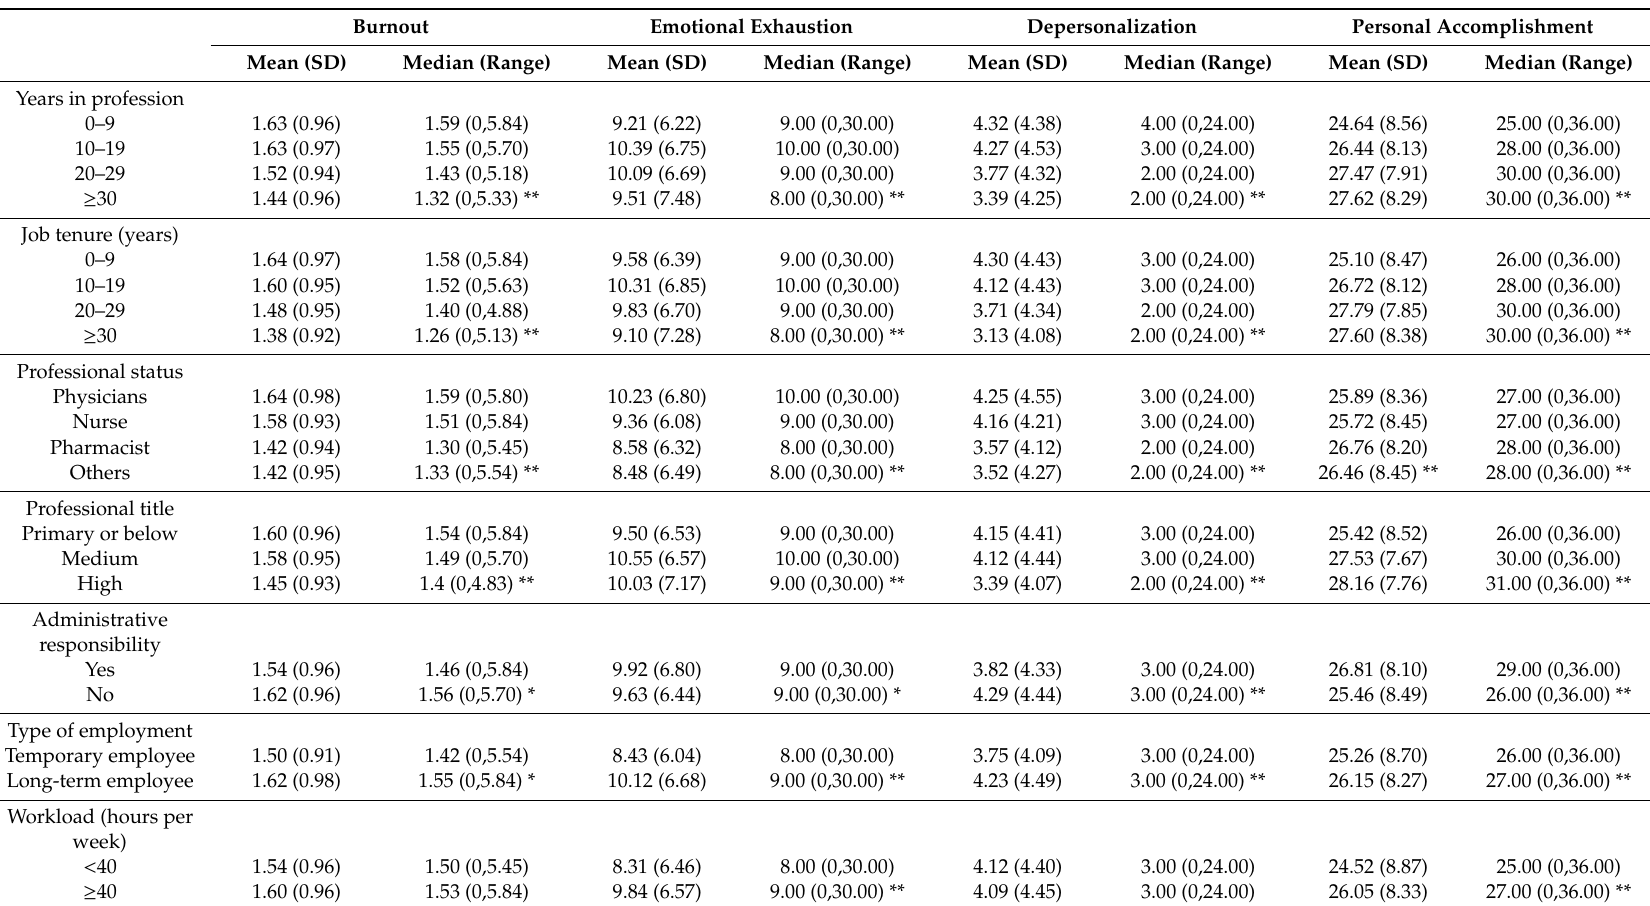
Table 5. The scores of burnout by occupational characteristics and the result of bivariate